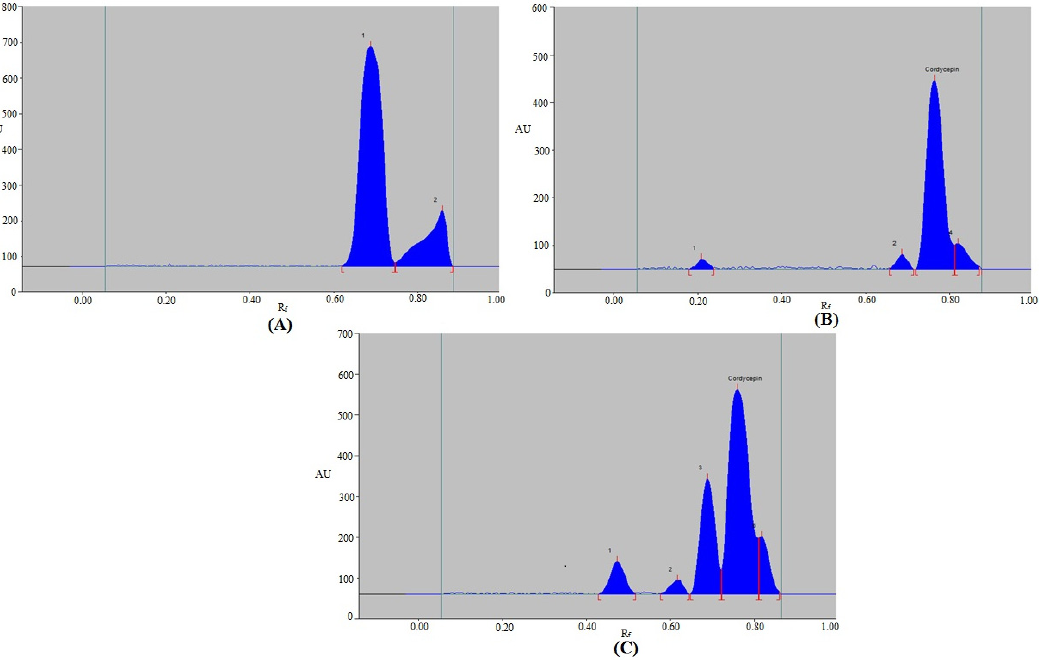
Figure 5. Representative densitometry chromatograms of CDN derived under ( A ) acid-, ( B ) alkali-, and ( C ) oxidative-induced degradation of CDN. Table 6. Results of forced degradation evaluation of CDN at various stress conditions for current protocols (mean ± SD; n = 3). Stress Condition